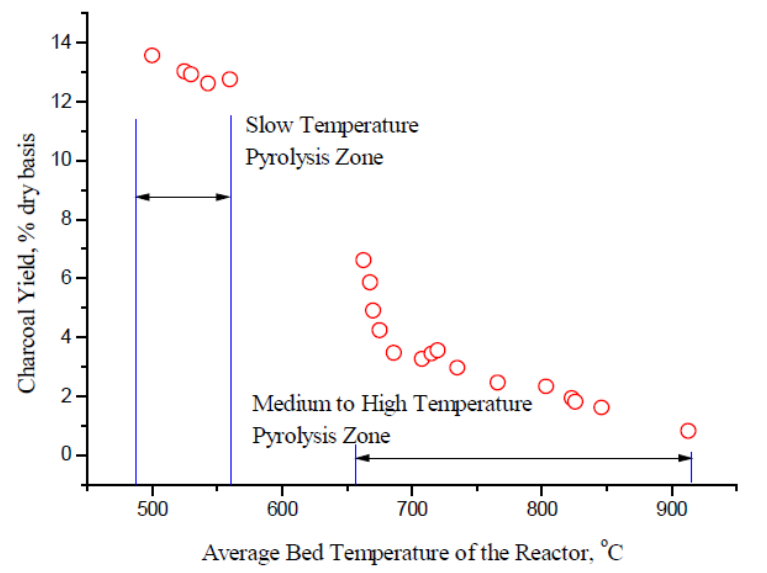
Figure 8. Charcoal (or bio-char) yields variation versus average temperature in the fluidised bed